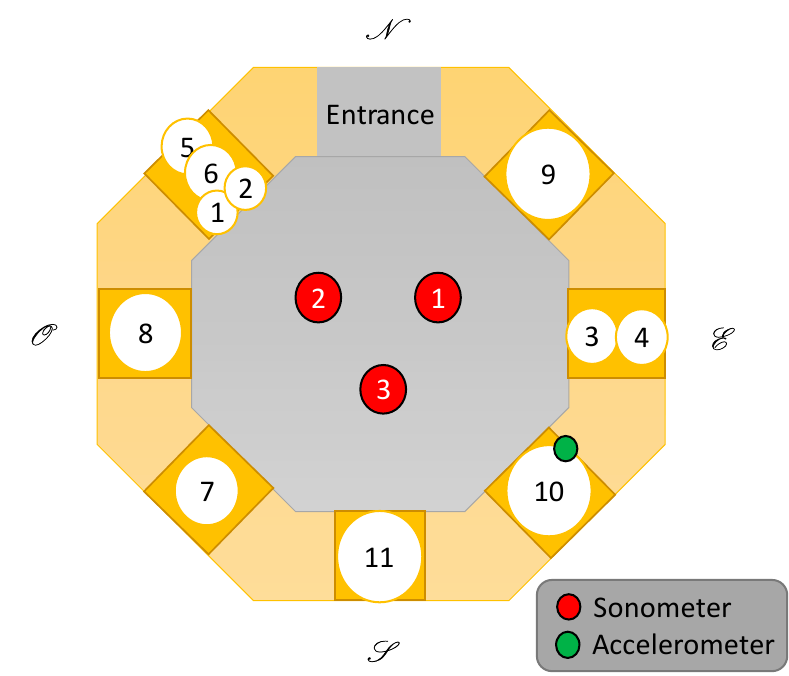
Figure 2. Deployment of the bells and position of the sonometers and the accelerometer.